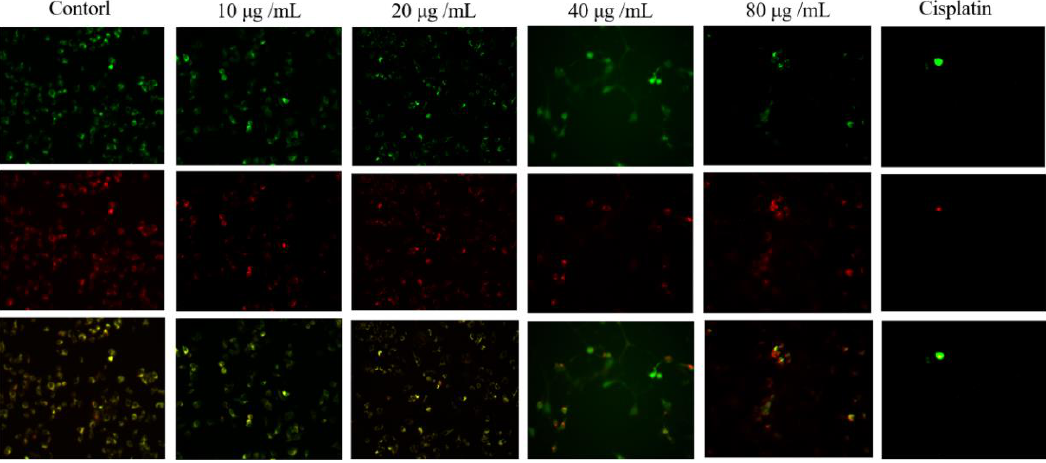
Figure 4. Effect of HSF on MMP levels in MCF-7 cells. Intracellular MMP levels were measured using Rh123 staining with an inverted fluorescence microscope. The phase contrast inverted microscopic images of the experimental groups (magnification, ×10).